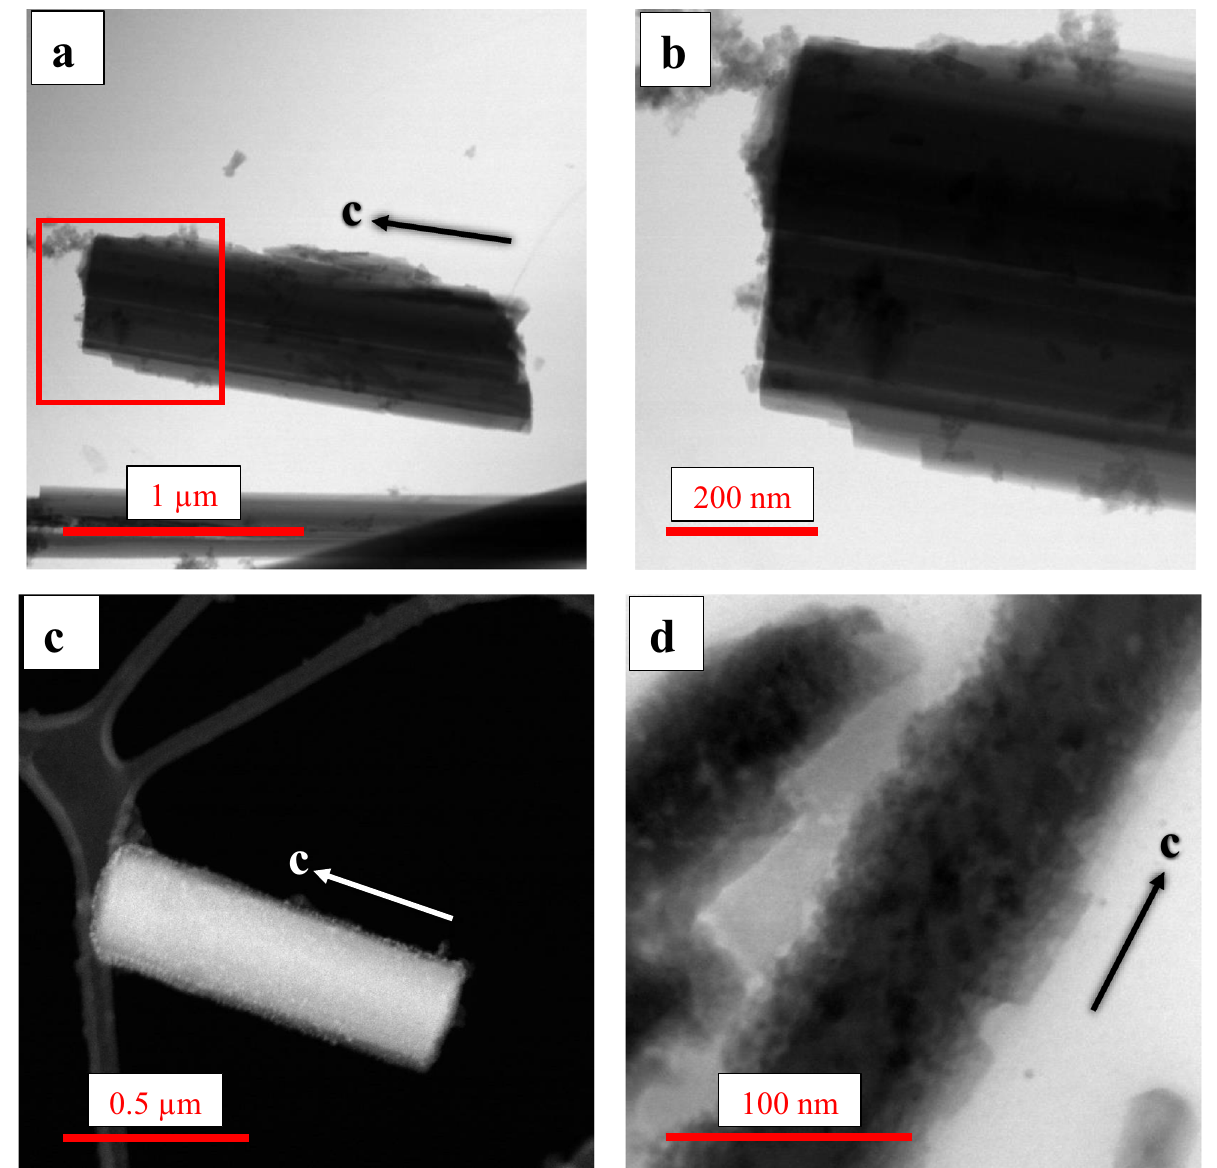
Figure 2. TEM images of amphiboles after interaction with AECs. ( a ) A nearly non-modified cleavage fragment of amosite; ( b ) Detail of the image shown in ( a ) (red square), in which stepped lamellar boundaries, rounded corners and streaking along the c -axis can be recognized; ( c ) acSTEM-HAADF image of an anthophyllite particle after interaction; the particle is completely covered by an Fe-rich layer containing several Fe-rich nanoparticles, which are visible as bright spots; ( d ) BF image of elongated particles of grunerite after interaction; particles display rough, highly modified grain boundaries, compromised morphology and clear signs of dissolution of the amorphous